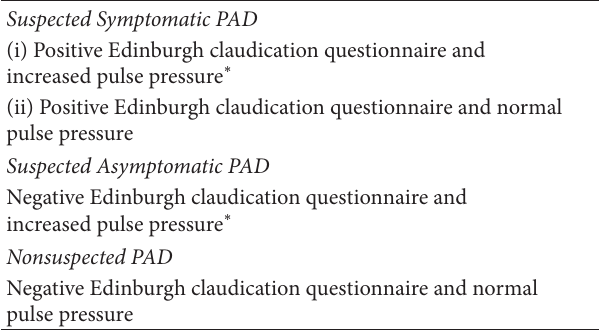
Table 2: Operational categories of PAD suspicion used in the Atahualpa